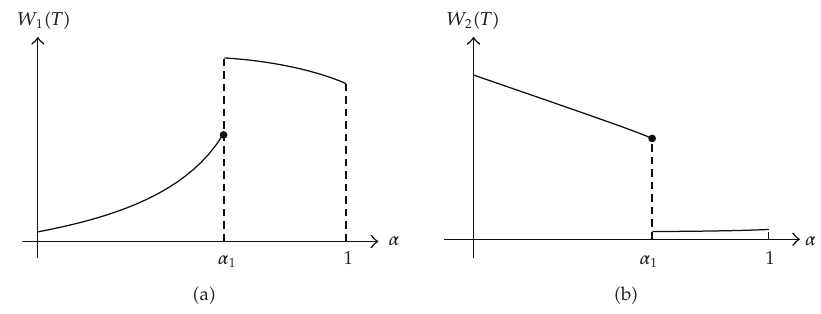
Figure 2: Case (cid:4) A (cid:7) : behaviour of W 1 and W 2 for su ffi ciently